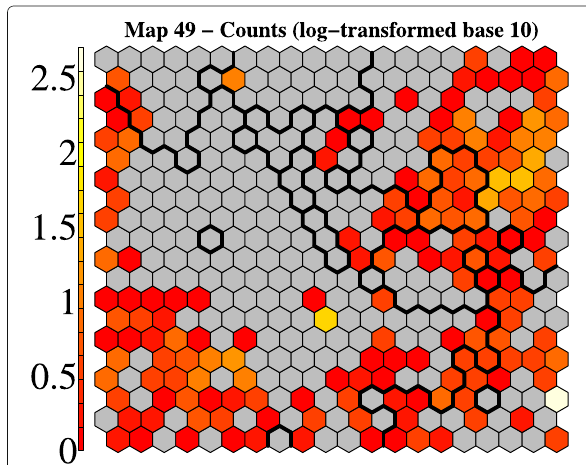
Fig. 10 High Fuel Consumption Trip mapped to SOM. Shows the mapping of the manoeuvres from the present trip to the map